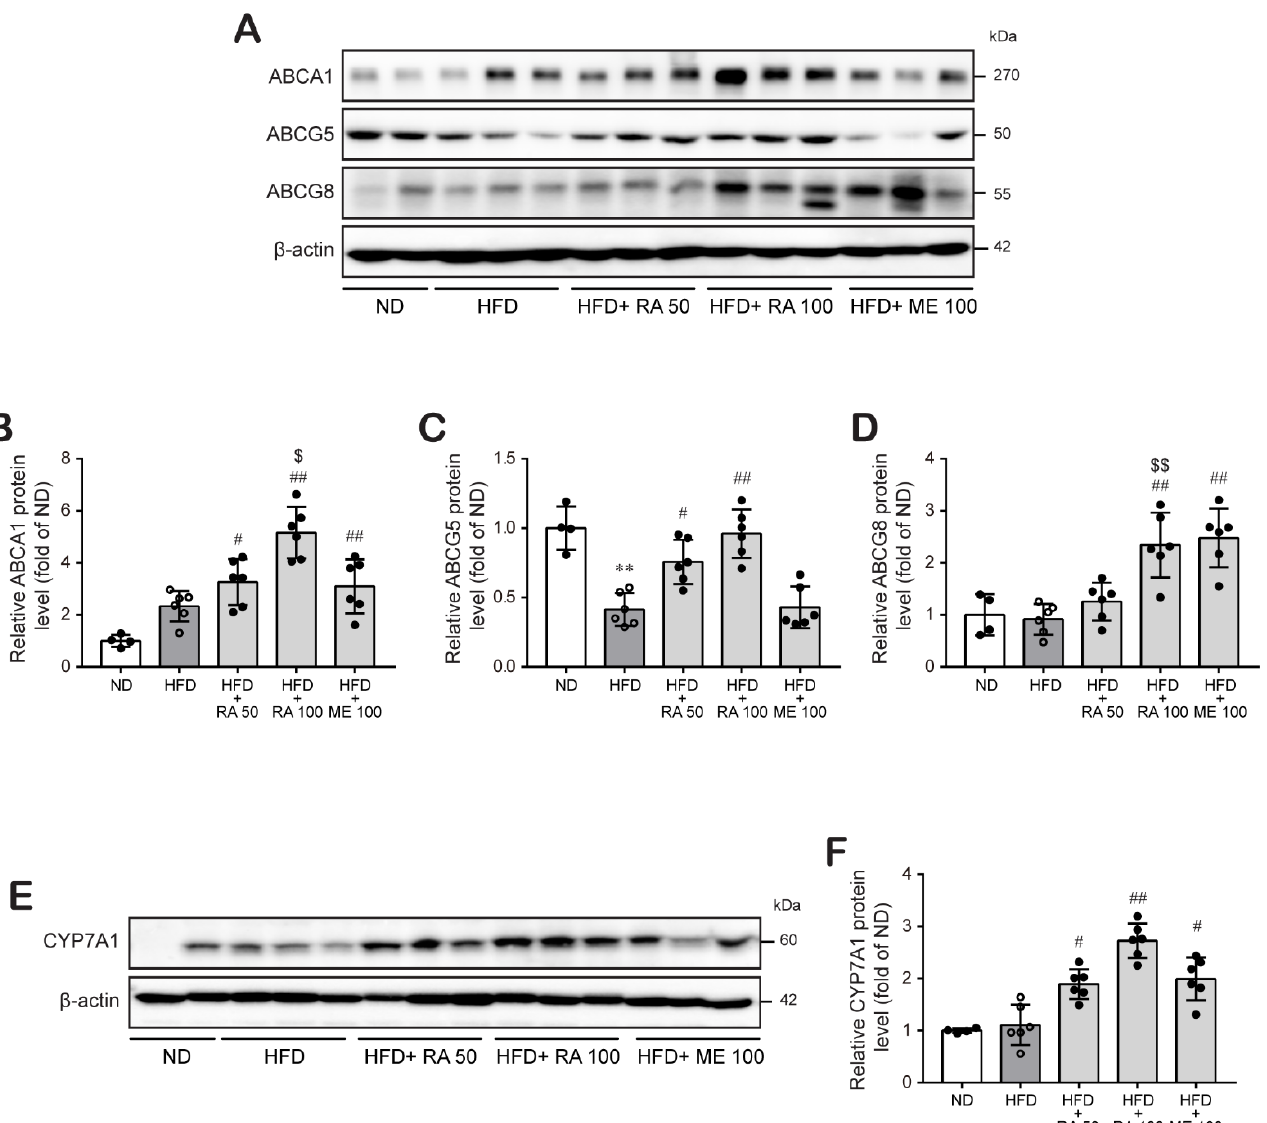
Figure 4. RA significantly induces ABCG5/8 and ABCA1 protein levels, which are involved in hepatobilial cholesterol excretion, and CYP7A1 protein levels, a key rate-limiting enzyme for bile acid biosynthesis in HFD-fed mice. ( A – D ) ABCG5, ABCG8, ABCA1, and ( E , F ) CYP7A1 protein levels were examined in liver tissues by western blot analysis, and the relative protein levels are presented as the mean ± SD (n = 4 – 6). ** p < 0.01 vs. ND control mice; # p < 0.05, ## p < 0.01, vs. HFD mice; $ p < 0.05, $$ p < 0.01 vs. RA 50.